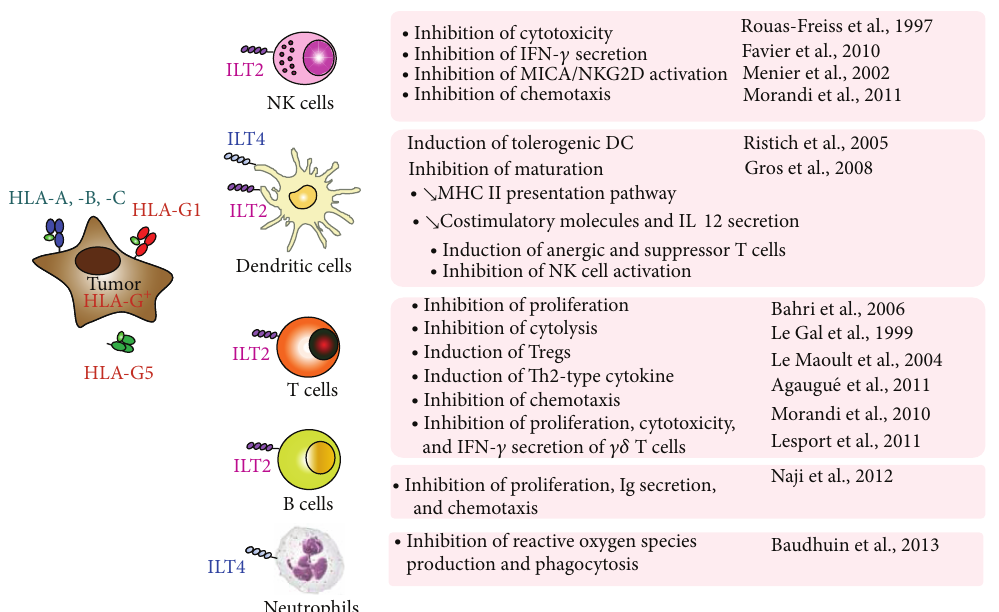
Figure 1: Tolerogenic functions of